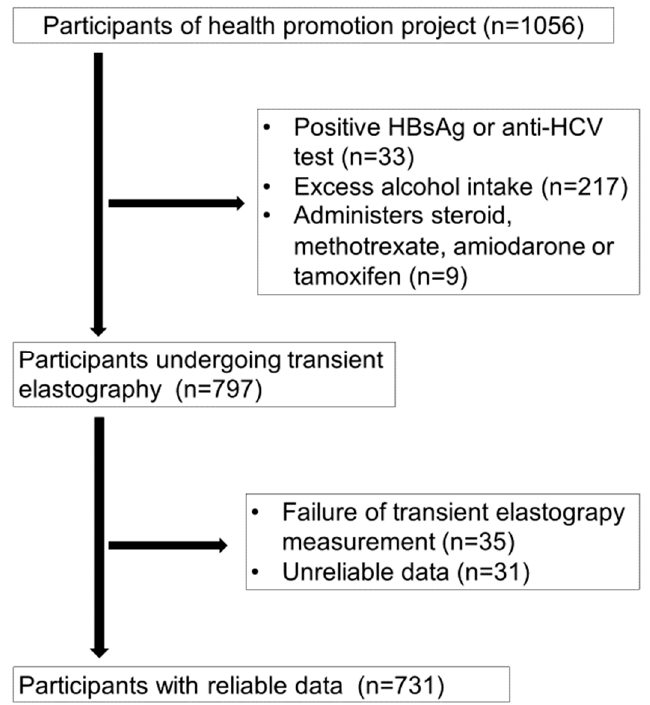
Figure 1. Study enrollment flow chart. Table 1. Participants’ characteristics at